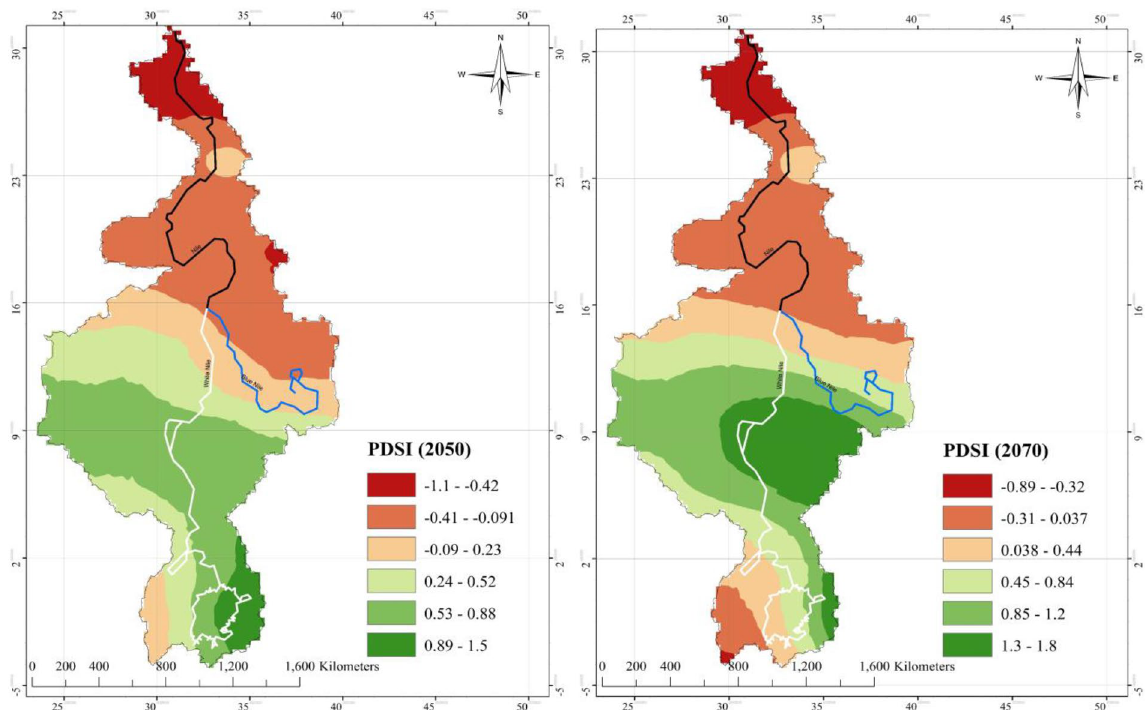
Figure 15. Future projection of drought severity ‘PDSI’ 2050,2070. According to sc-PDSI projection, large parts of Egypt and Sudan could suffer mild to moderate hydrologic droughts over the 21st Century, and countries such as Kenya, Tanzania, Rwanda, Burundi, Uganda, and Congo are projected to suffer incipient droughts. Major areas of Egypt and Sudan is projected to have mild to moderate drought, this can be explained by the very high increase in projected Ts. Between 2050 and 2070 as the increase in mean temperature is lower than the previous period and precipitation increase is also lower, the entire region is covered by incipient drought (mainly Egypt and Sudan-except the White Nile region) and slightly wet to moderately wet in Kenya, Tanzania, Rwanda, Burundi, Uganda, and Congo and Ethiopia. This reflects the effect of warming rate in future